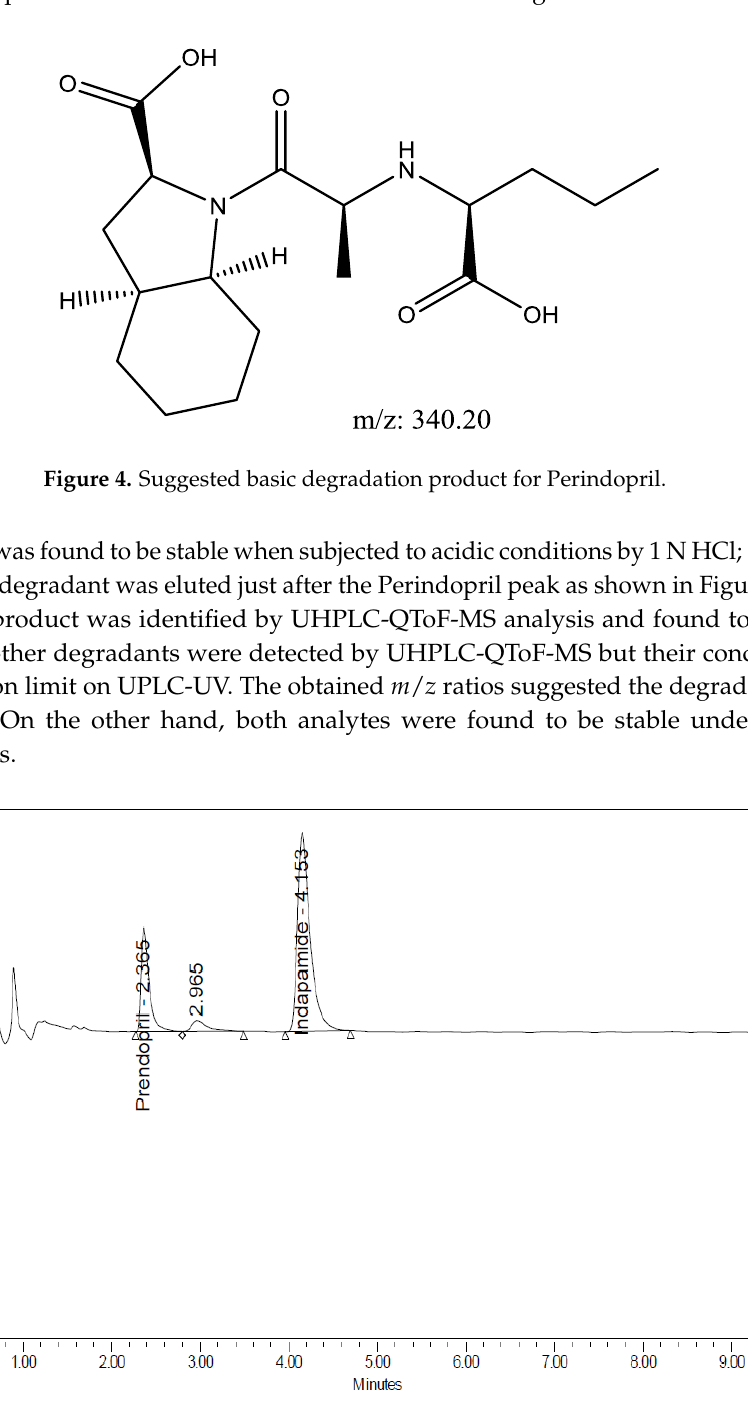
Figure 5. UHPLC-UV chromatogram for the acidic degradation products of Perindopril.